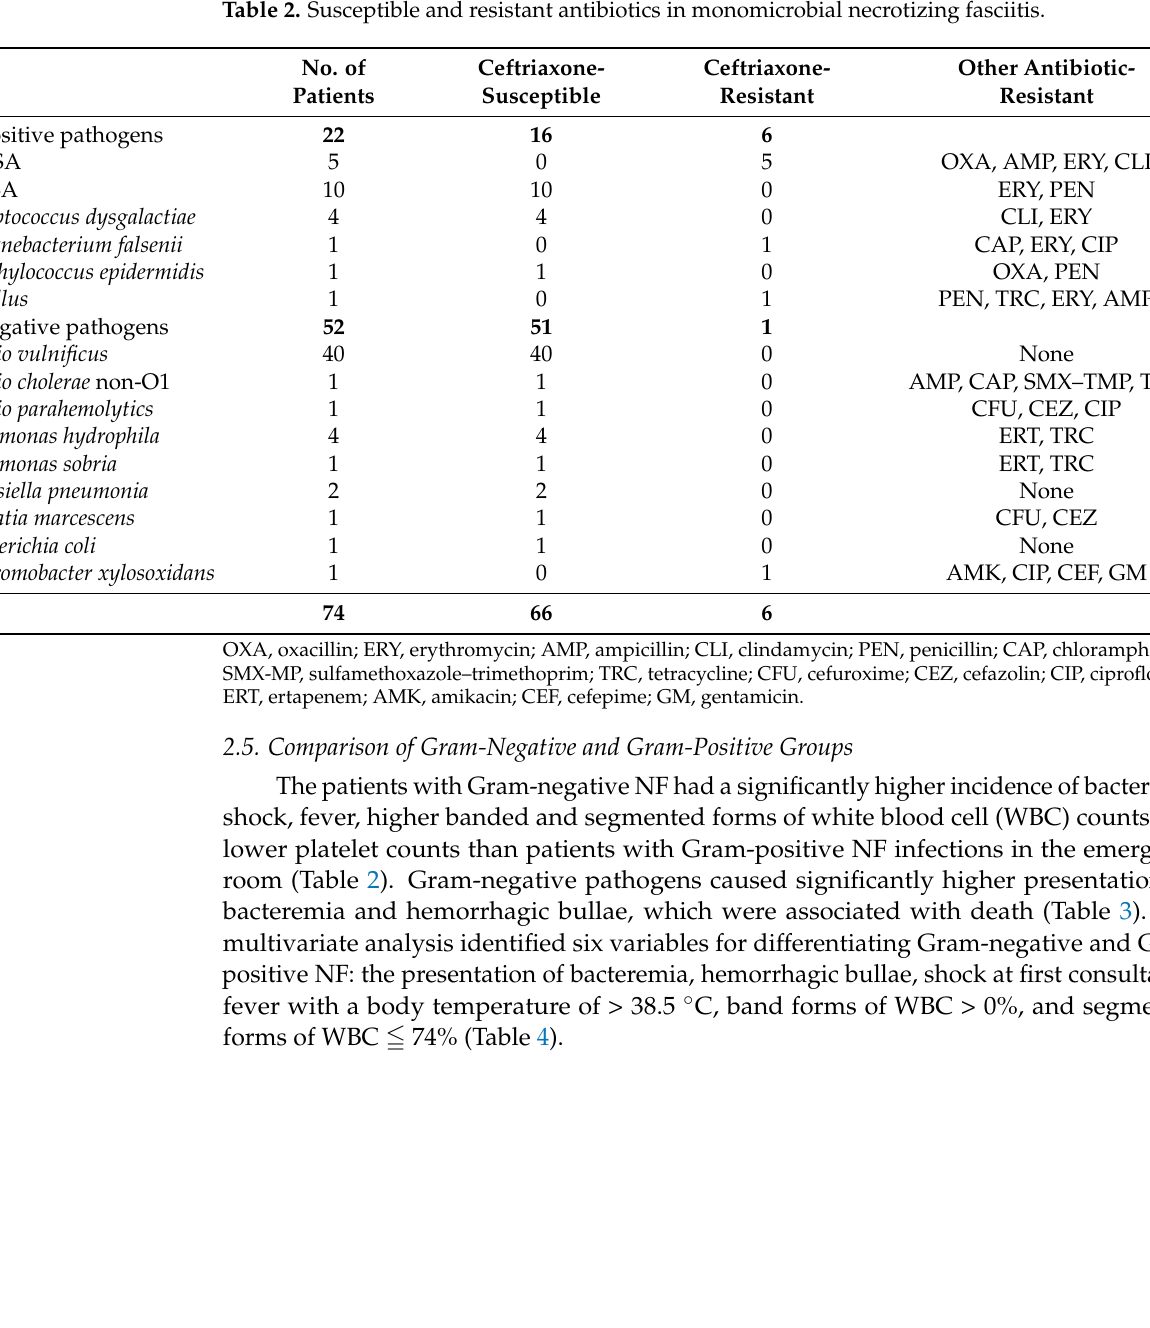
Table 2. Susceptible and resistant antibiotics in monomicrobial necrotizing